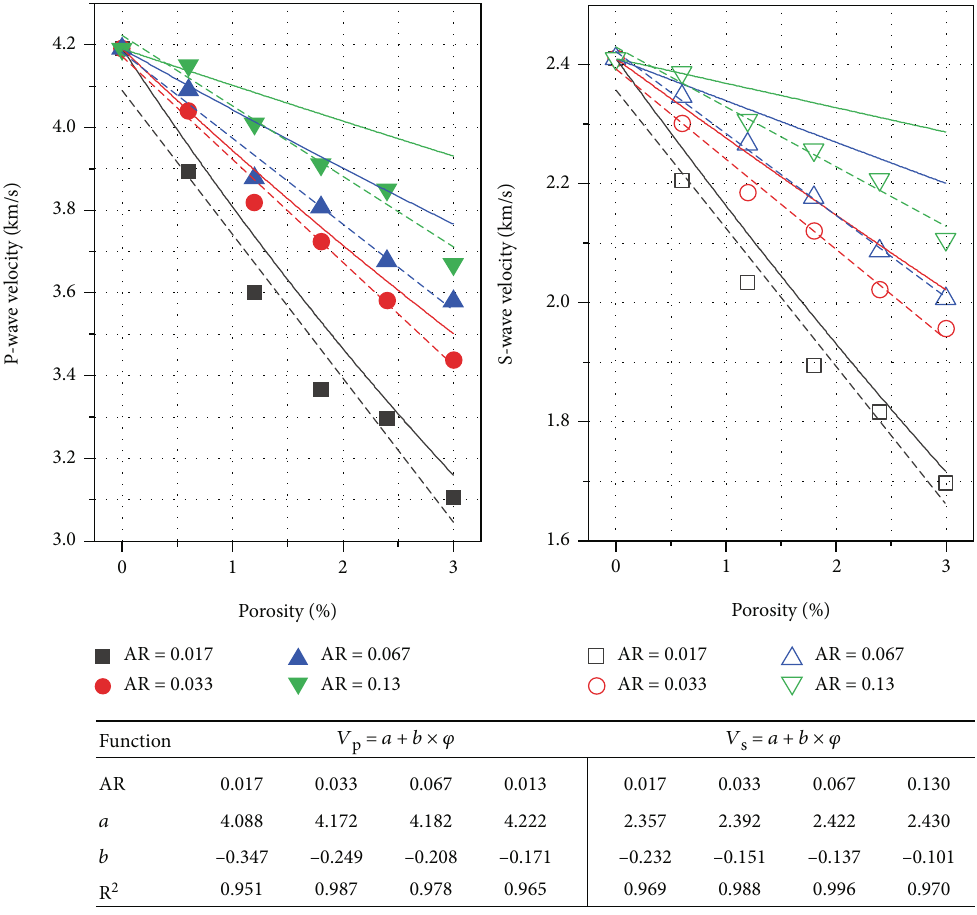
Figure 6: The V (solid points) and V (hollow points) of the four model sets. The dashed lines are fi tted by linear functions for the di ff erent P S porosities. The solid lines are obtained using DEM concepts with pore AR of 0.017, 0.033, 0.067, and 0.13. Table 4: Parameters used for DEM model calculation. Materials Density (g/cm 3 ) V (m/s) V (m/s) P S Matrix 2.41 Silicon